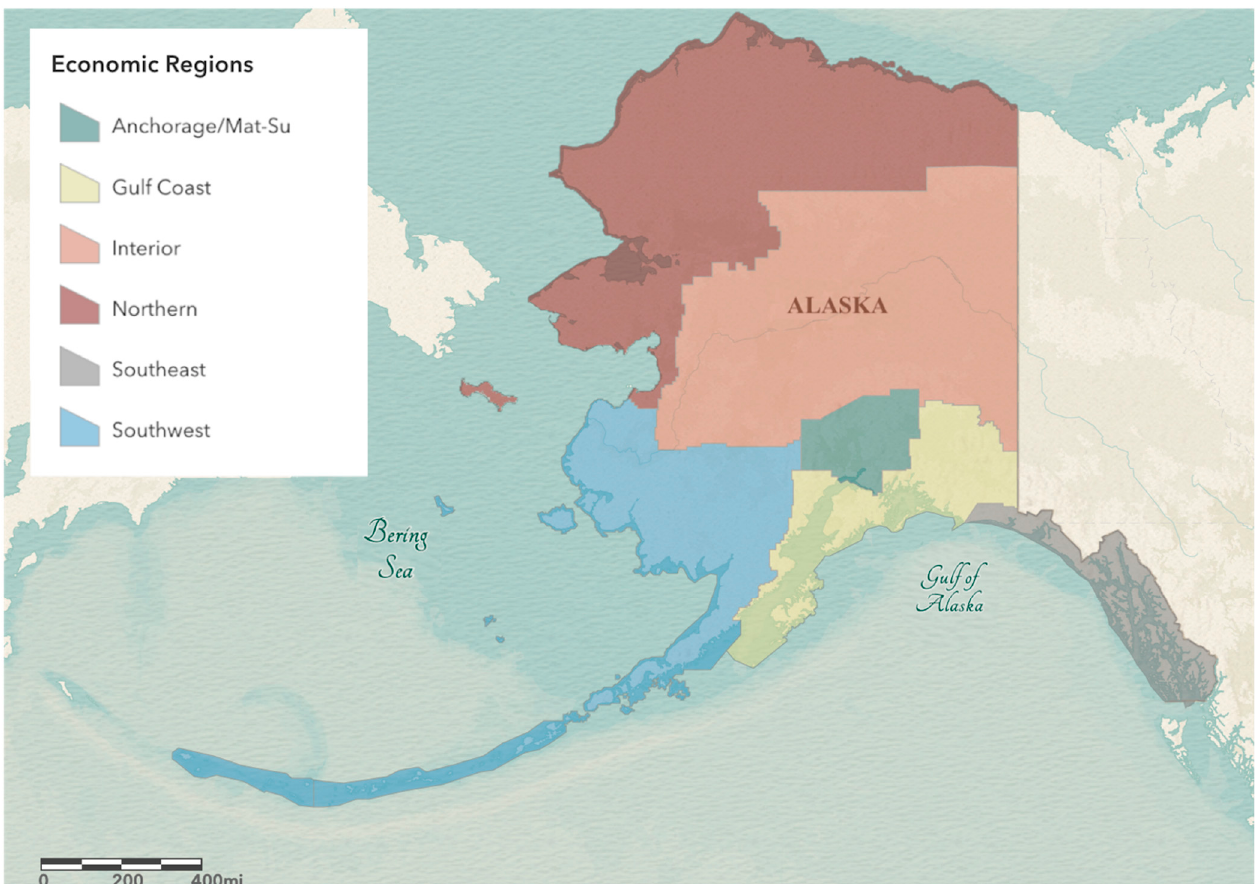
Figure 1. Map of Alaska with economic regions designated by Alaska Department of Labor and Workforce Development. Anchorage is found in the Anchorage/Mat-Su region. Fairbanks is found in the Interior region.